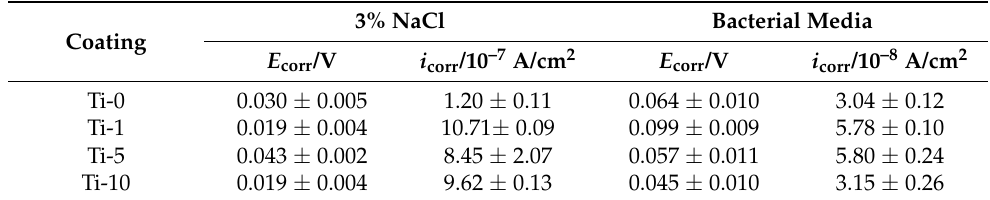
Figure 10. Potentiodynamic polarization curves of Cu – Sn and Cu – Sn – TiO 2 coatings after 15 min exposure to 3% NaCl solution ( a ) and bacterial media ( b ). Table 3. Parameters of corrosion process extracted from potentiodynamic polarization curves.